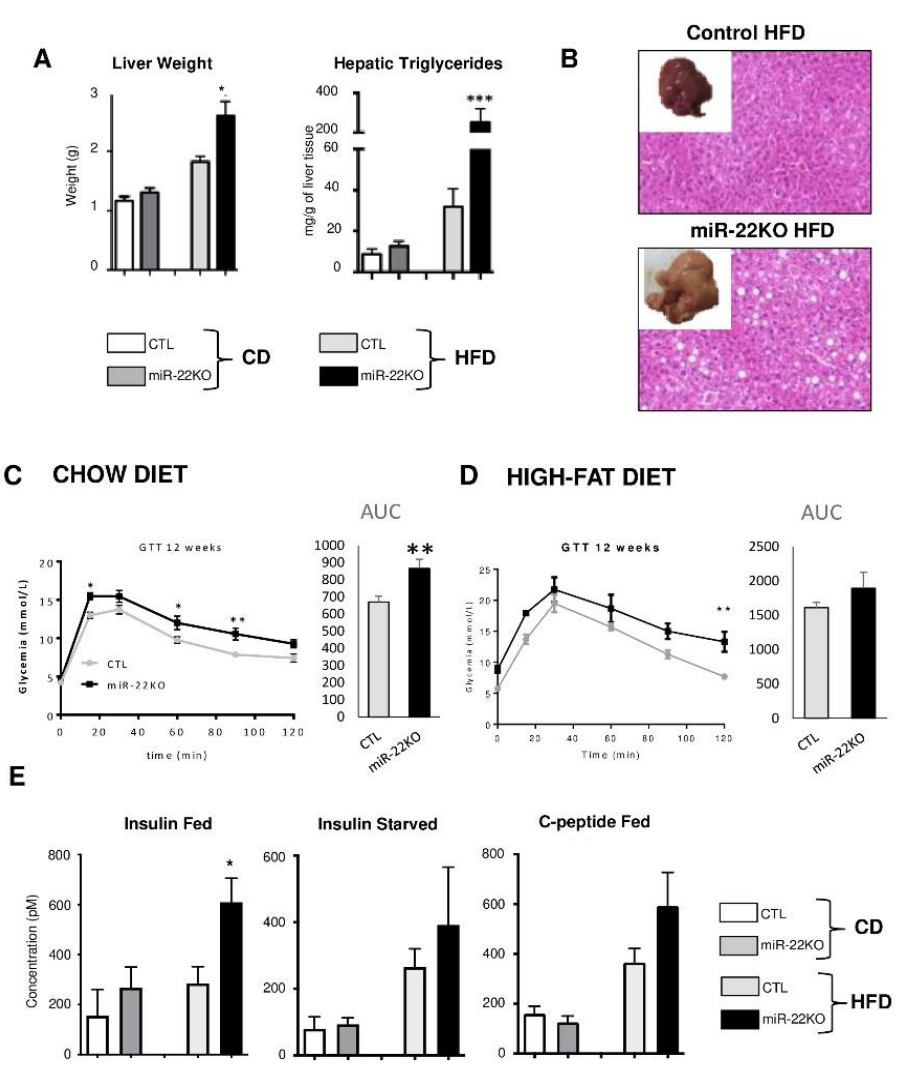
Figure 3. Mir22 deficiency fosters obesity-associated hepatomegaly, hepatic steatosis and glucose intolerance. Two-months-old CTL and miR-22KO mice were fed CD and HFD for 12 weeks: ( A ) liver weights and hepatic triglycerides contents. ( B ) Representative liver anatomies and hematoxylin and eosin (H&E) staining of liver sections from CTL and miR-22KO mice fed HFD. ( C , D ) Glucose tolerance test (GTT) and calculated areas under the curve (AUC) in CTL and miR-22KO mice fed CD or HFD for 12 weeks (n = 5–10 per group, data are represented as means ± SEM). ( E ) Insulinemia and C-peptide plasma concentration in fed and starved mice. (n = 3–10 per group, data are means ± SEM). Statistical tests were performed: two-way ANOVA * p < 0.05, ** p < 0.01, *** p <